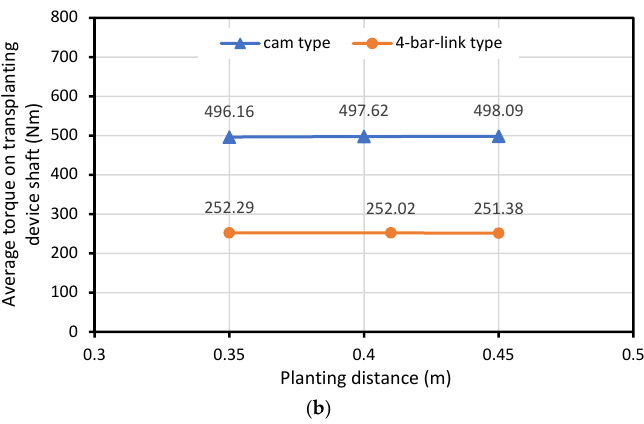
Figure 13. Comparison of torque on the transplanting device input shaft between cam and four-bar- link types according to working conditions: ( a ) engine speed and ( b ) planting distance.